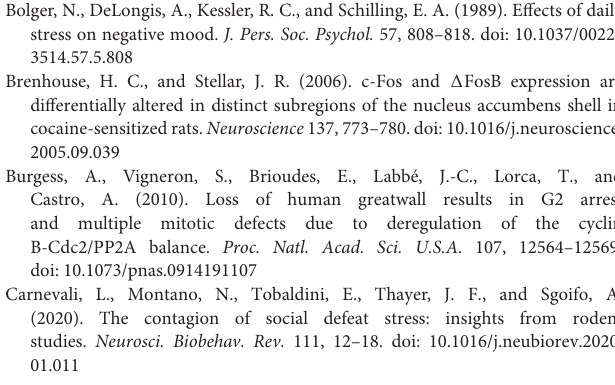
Supplementary Figure 1 | Photomicrographs depicting the anterogradely labeled neurons in the mPFC. (A) BDA microinjection site in the left PrL (scale bar = 100 µ m). (B) White arrows show the presence of labeled neurons in the right PrL (scale bar = 50 µ m). BDA (Dextran Amine-Texas Red R (cid:13) , Biotinylated), antegrade neurotracer. Supplementary Figure 2 | Representative photomicrographs of a representative microinfusion site. (A) Photomicrograph of a representative microinfusion site (black arrow) within the left prelimbic (Experiment 5). (B) Photomicrograph of a representative microinfusion site (black arrows) within the left and right prelimbic (Experiment 6). (C) Representative photomicrograph of the off-target microinfusion site (black arrows). Section corresponds to 1.94 mm anterior to bregma (Paxinos and Franklin, 2001). Scale bar = 1000 µ m. Cg1, cingulate cortex, area 1; PrL, prelimbic cortex; IL, infralimbic cortex; fmi, forceps minor of the corpus